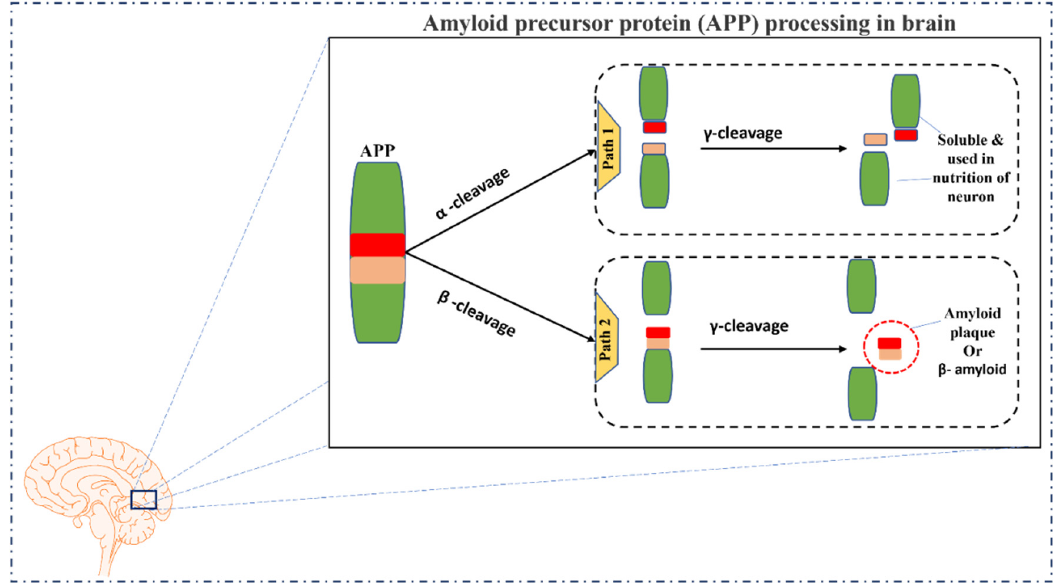
Figure 2. Pathophysiology of Alzheimer’s disease (AD) in the brain. The metabolism of APP follows either a non-amyloidogenic pathway through α -secretase cleavage or an amyloidogenic pathway through cleavage mediated by β -site APP cleaving enzyme 1 (BACE1).